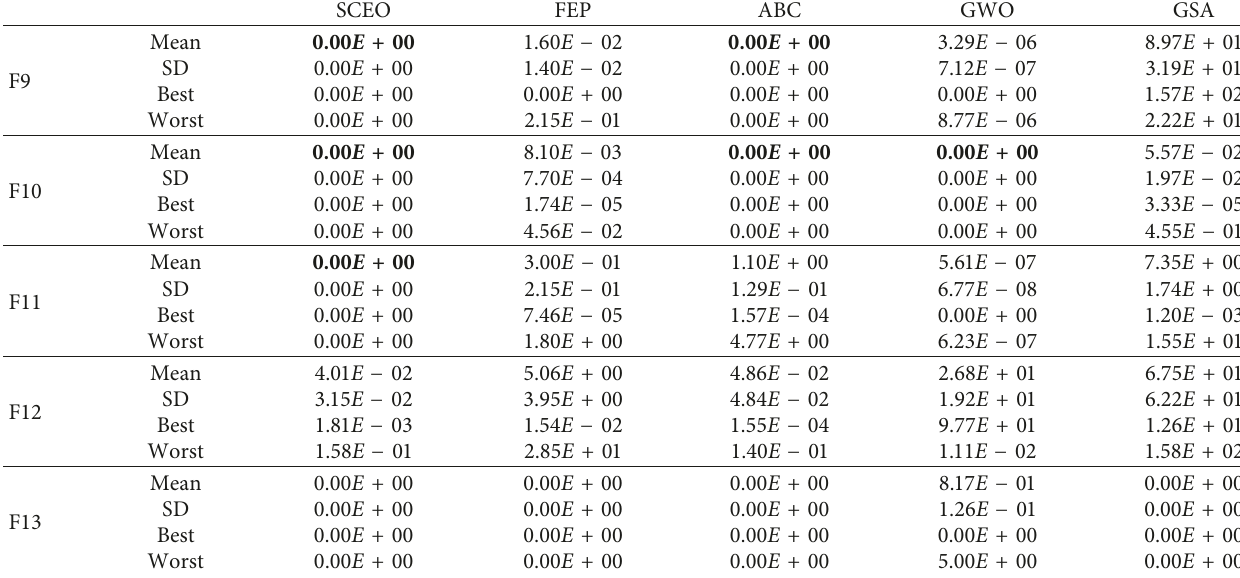
Table 7: Comparison with FEP [15], ABC [29], GWO [7], and GSA